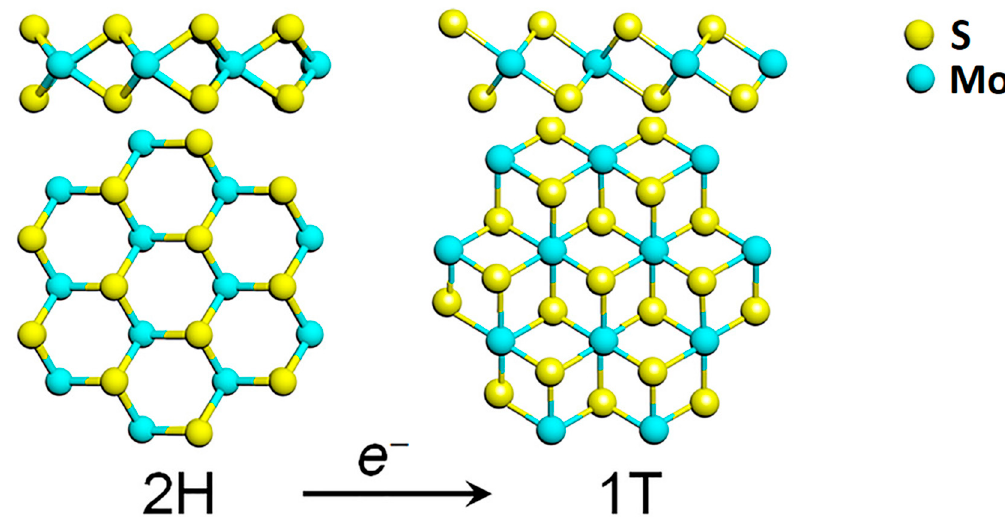
Figure 1. Transformation of the hexagonal 2H polymorph of MoS 2 into its 1T phase, through electron transfer. Reprinted with permission from ref. [6]. © 2017 AIP Publishing.